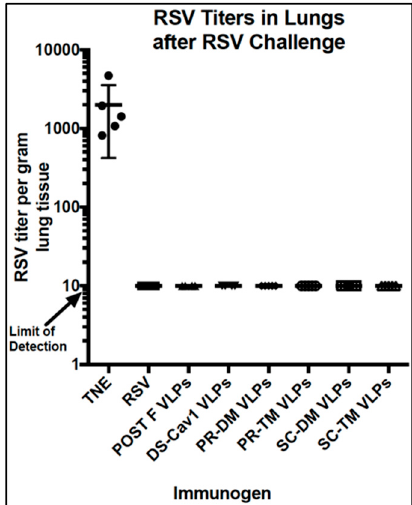
Figure 9. RSV replication upon RSV challenge of VLP Immunized mice. Mice were primed with VLPs or RSV infected at day 0 and boosted at day 100. At day 147, the mice were infected with RSV (1 × 10 6 pfu/animal) and four days later, mice were sacrificed and the titers of RSV per gram of lung tissue were determined. No virus was detected above the detection limit for all immunized animals.